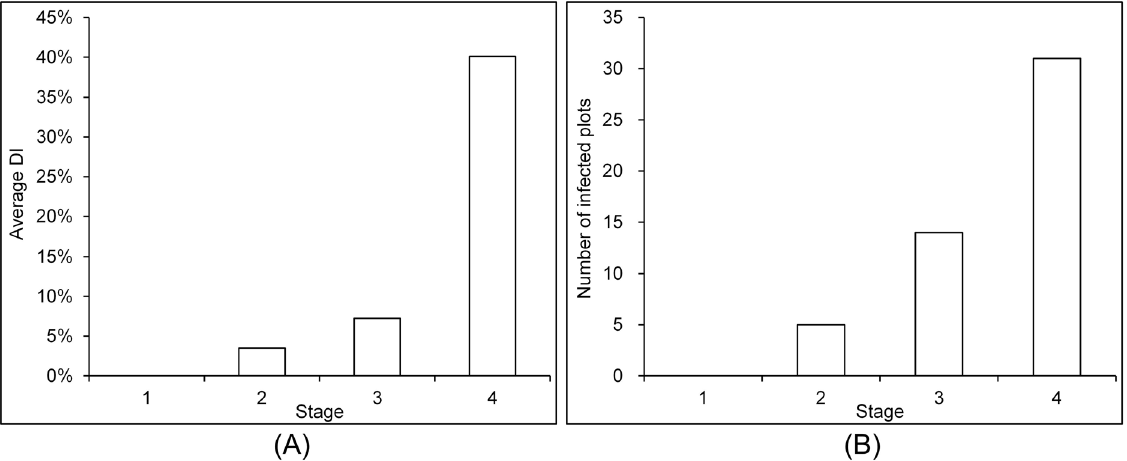
Figure 5. The number of infected plots and their average DI s at different stages ( n = 90).